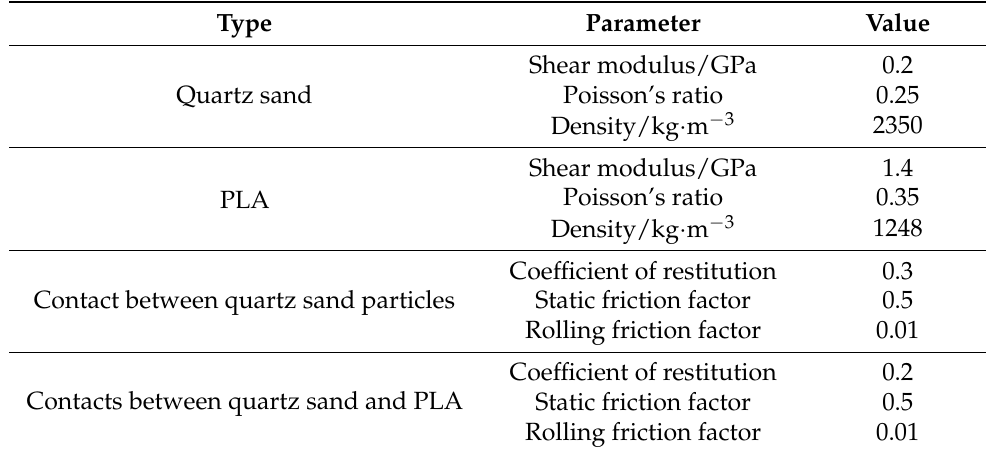
Table 1. Material properties and contact